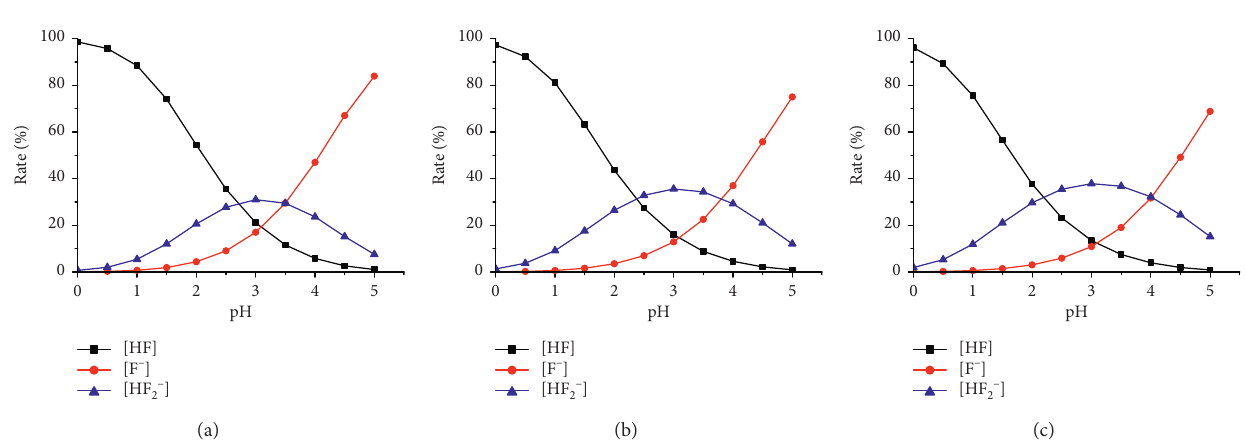
Figure 4: Variation in the proportion of different bodies in different concentrations of HF solution with pH: (a) 5% concentration HF; (b) 10% concentration HF; (c) 15% concentration